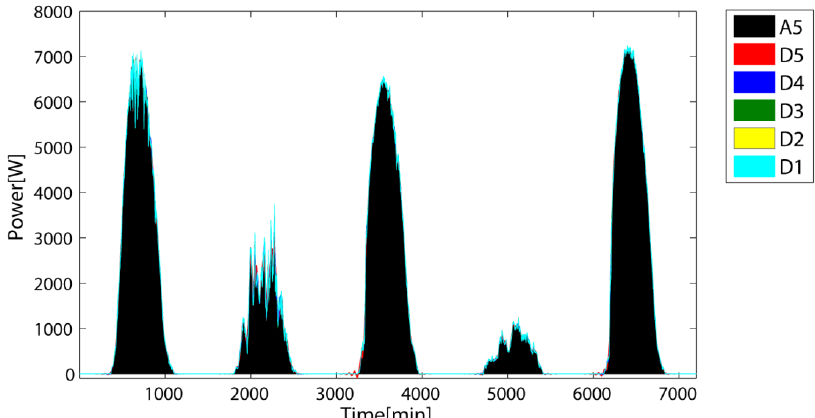
Figure 5. Area graph at each layer.